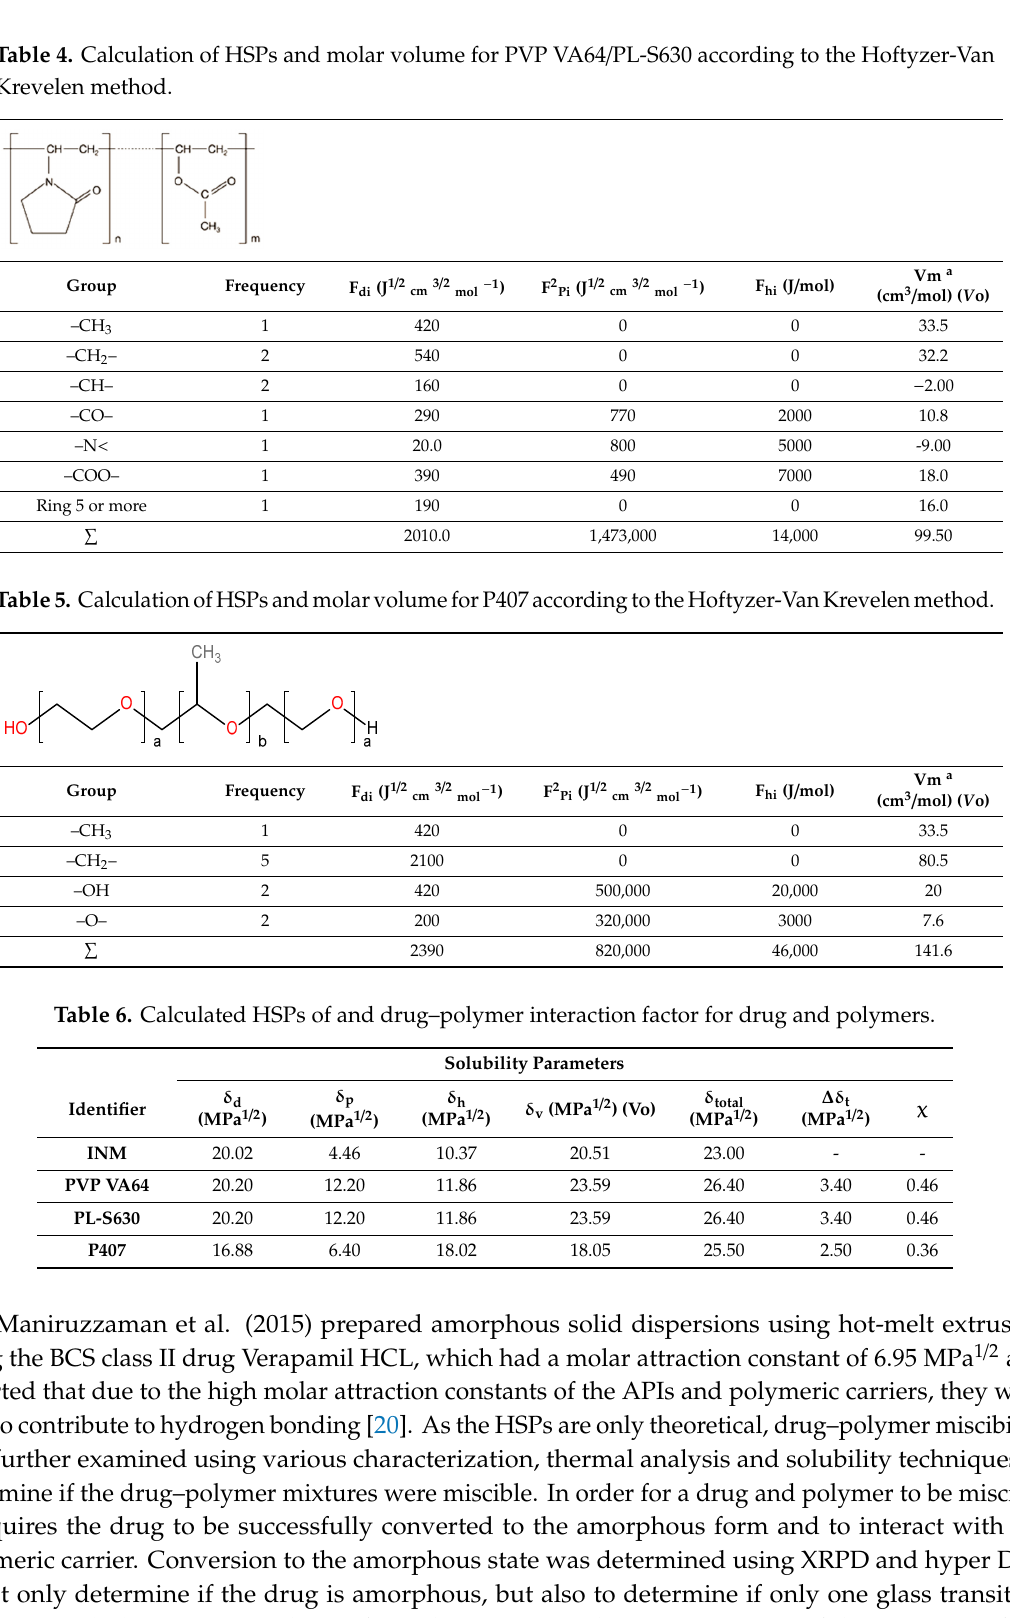
Table 4. Calculation of HSPs and molar volume for PVP VA64 / PL-S630 according to the Hoftyzer-Van Krevelen method.